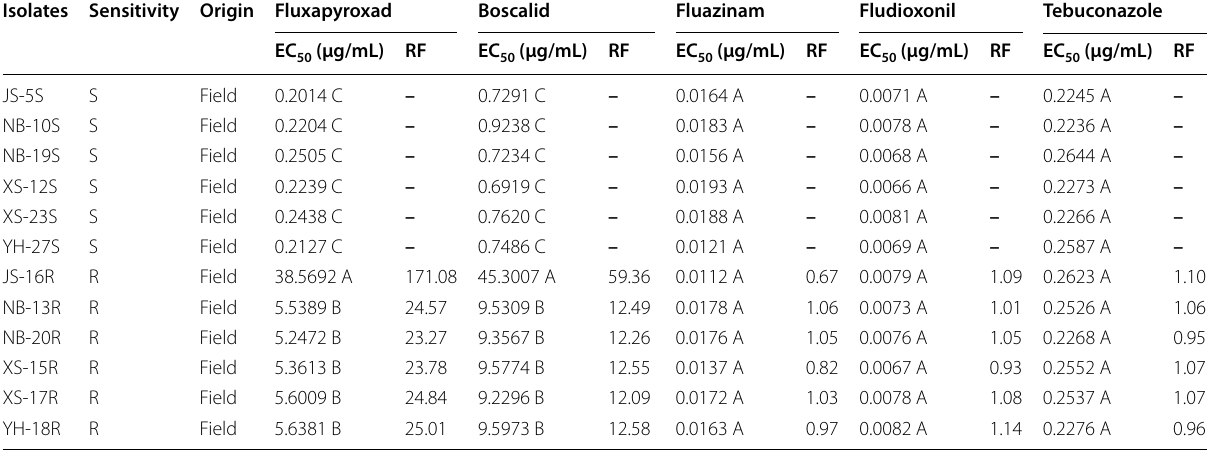
RF, resistance factor, the ratio of EC 50 of a FluR isolate relative to the mean value of EC 50 of FluS isolates S indicates an isolate is sensitive to fluxapyroxad; R indicates an isolate is resistant to fluxapyroxad